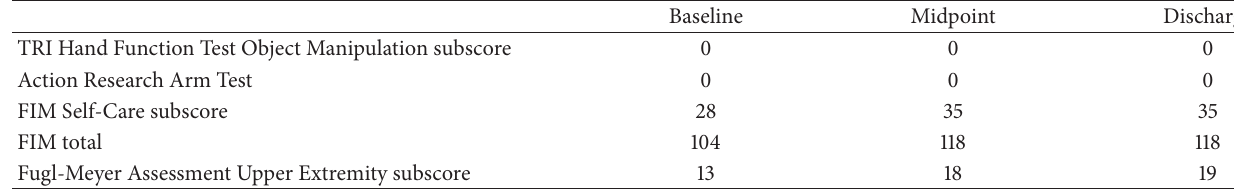
Table 4: Performed